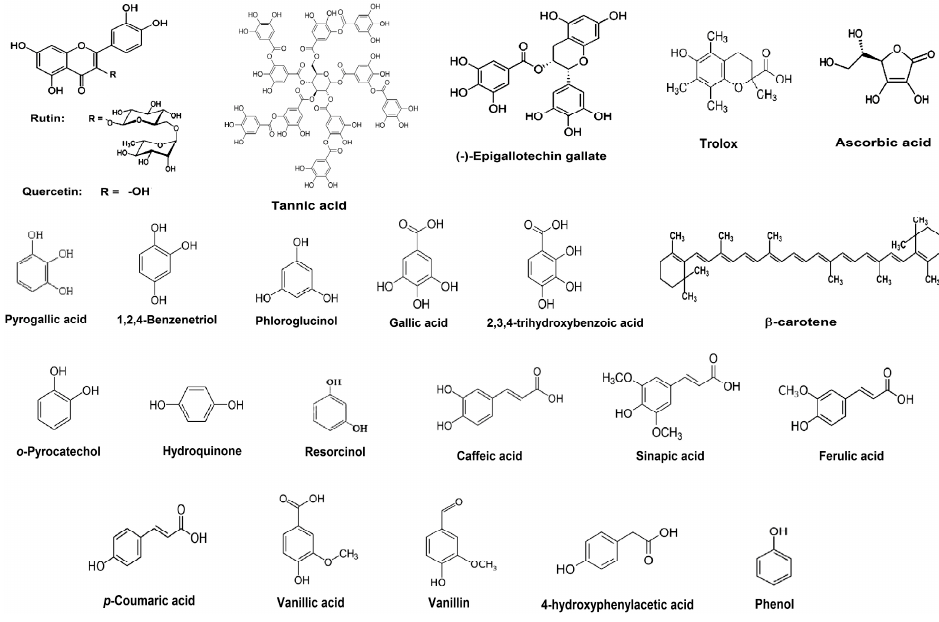
Figure 2. The formulas of antioxidant compounds examined with the proposed method.